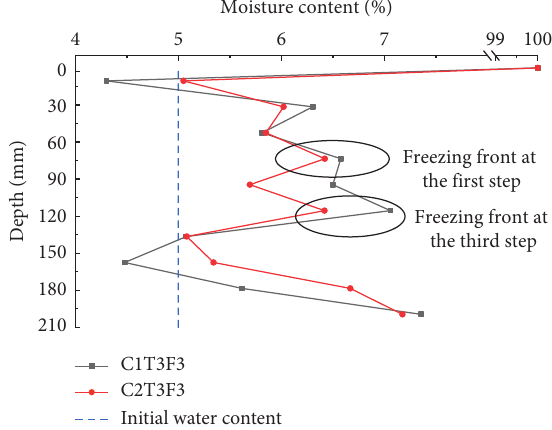
Figure 6: The final moisture content distributions of C1T3F3 and